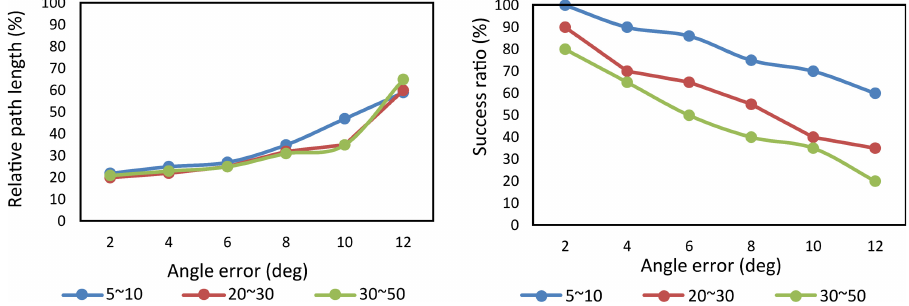
Fig. 9. Three experiments with 500 trials constructed where di®erent number of RFID tag numbers (5 – 50) used in terms of angle [left] and path distance [right]. Highest accuracy observed (92.3%) with a 20 – 30 tag number and 60m of path distance.